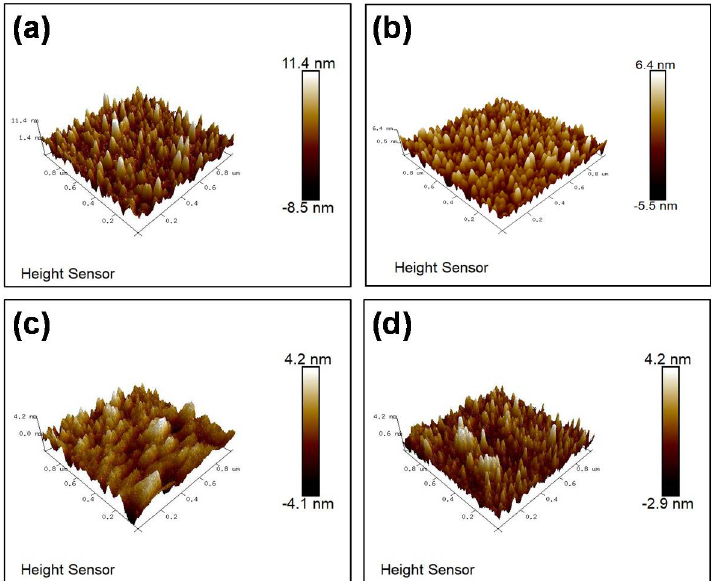
Figure 5. AFM images of ITZO films deposited with pulse off-times of ( a ) 0 μs, ( b ) 500 μs, ( c ) 1000 μs, and ( d ) 2000 μs.